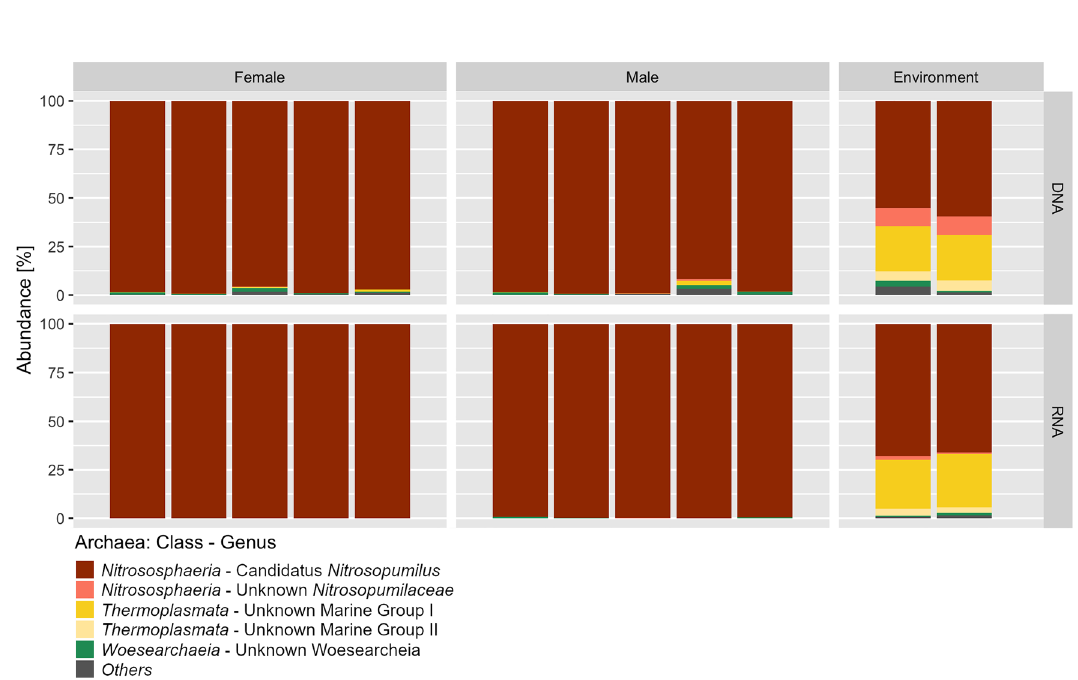
Figure 7. Abundance of aASVs in sea water and M. alvisca samples, displayed on genus-level or, if that was not possible, on the next identifiable superordinated rank. Others: taxa with < 0.5%